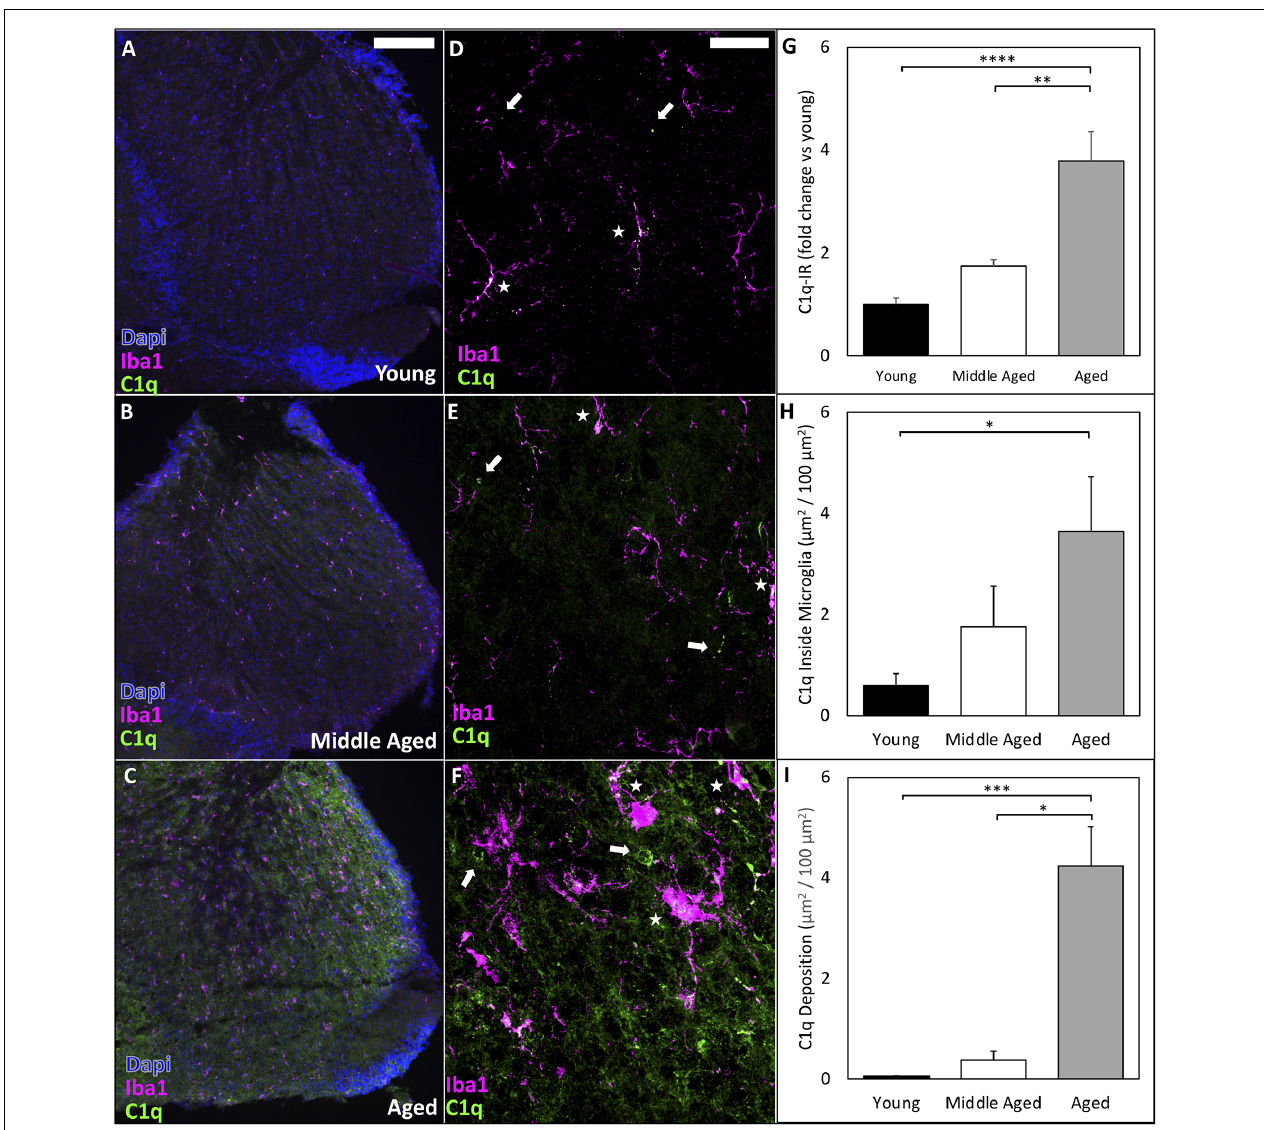
FIGURE 4 | C1q deposition in the CN dramatically increases during ARHL. (A–C) Representative images to show that C1q-IR is progressively increased throughout the CN during aging. Scale bar = 200 µ m. (D–F) High resolution confocal imaging reveals intracellular C1q inside microglia dramatically increases in aging. Arrows: C1q deposited on tissue outside of microglia; Stars: internal C1q inside microglia. Scale bar = 25 µ m. (G) Quantification of C1q-IR by mean fluorescence intensity analyzed by ImageJ shows significantly increased C1q-IR across the lifespan. ∗∗ p < 0.01; ∗∗∗∗ p < 0.0001. (H) C1q levels rise inside microglia across aging. ∗ p < 0.05. (I) The total amount of C1q deposition increases with age. ∗ p < 0.05; ∗∗∗ p <